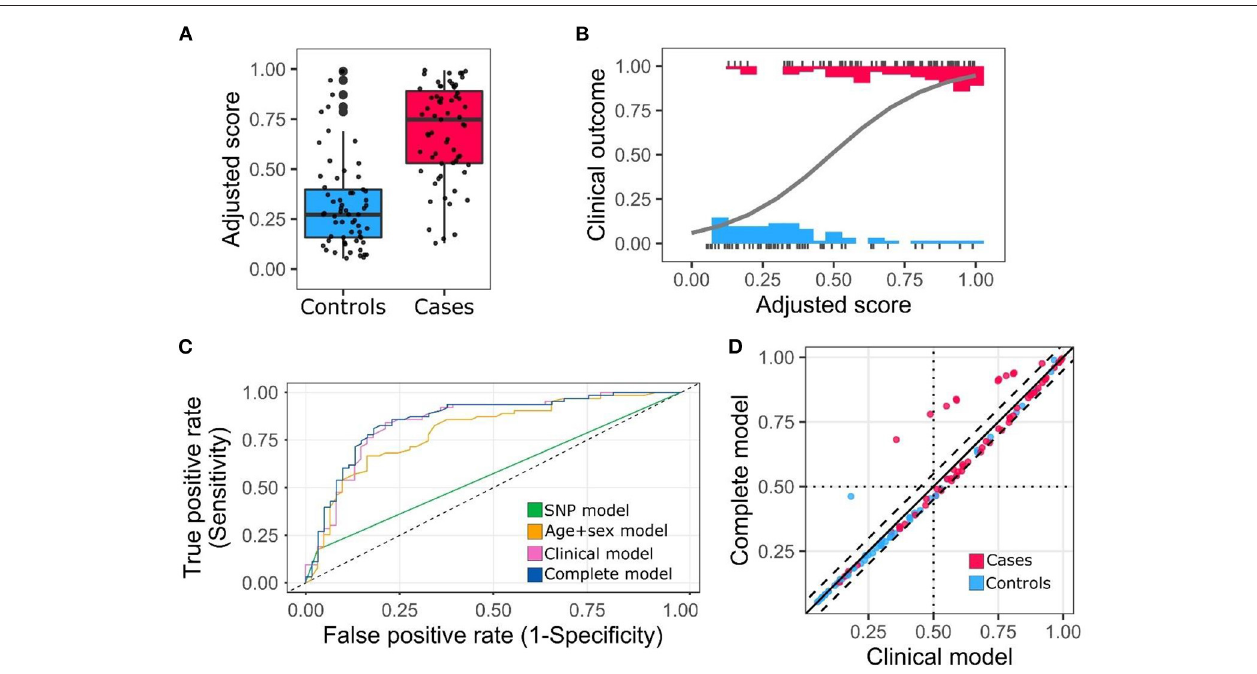
FIGURE 2 | Adjusted score distribution for cases and controls and ROC curve. (A) Box plot of the adjusted scores categorized by cases and controls. (B) Distribution and regression model for adjusted scores. Clinical outcome 0 corresponds to non-hospitalization and 1 to hospitalization. (C) Receiver operating characteristic (ROC) curve. (D) Score comparison clinical model vs. complete model. Dashed lines cutoff value ±